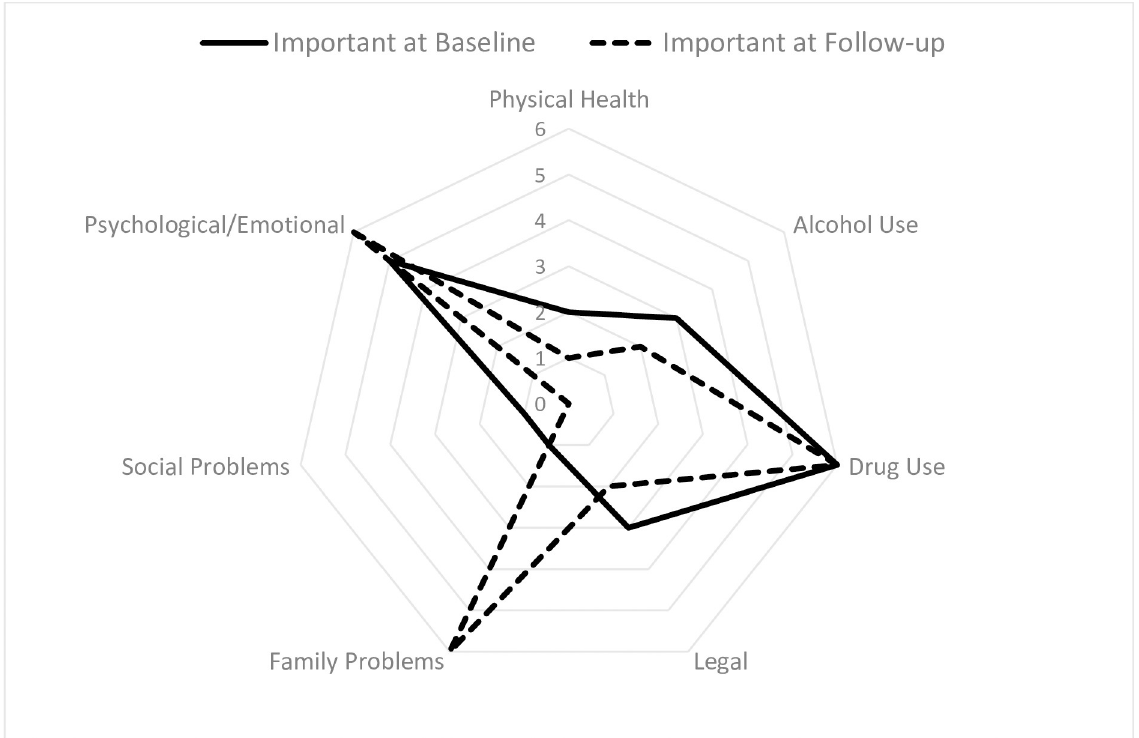
Fig 2. Number of clients reporting each ASI category as being “Important” at baseline and